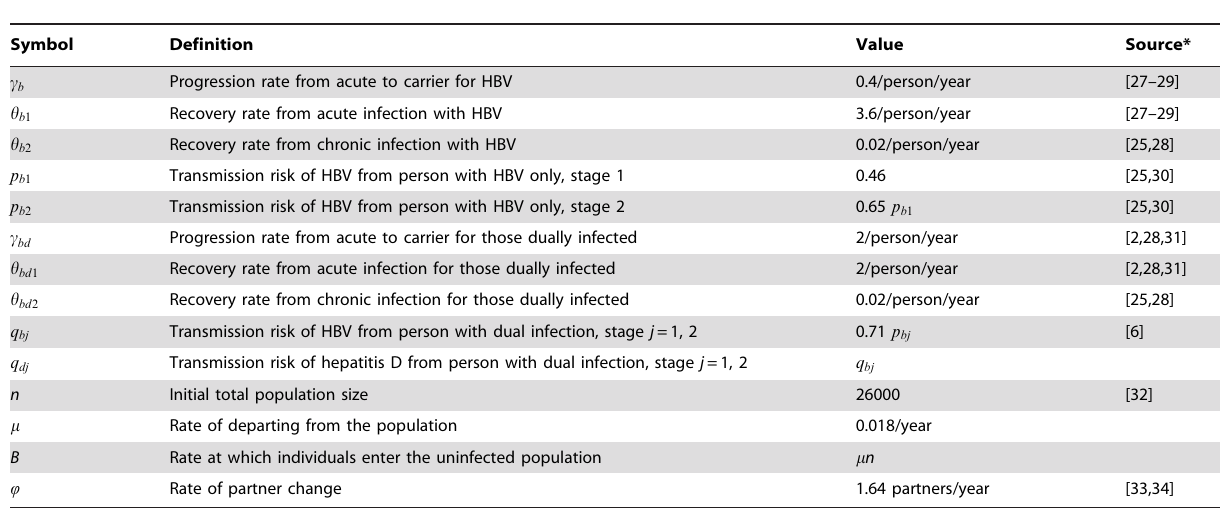
Table 1. Parameter definitions and